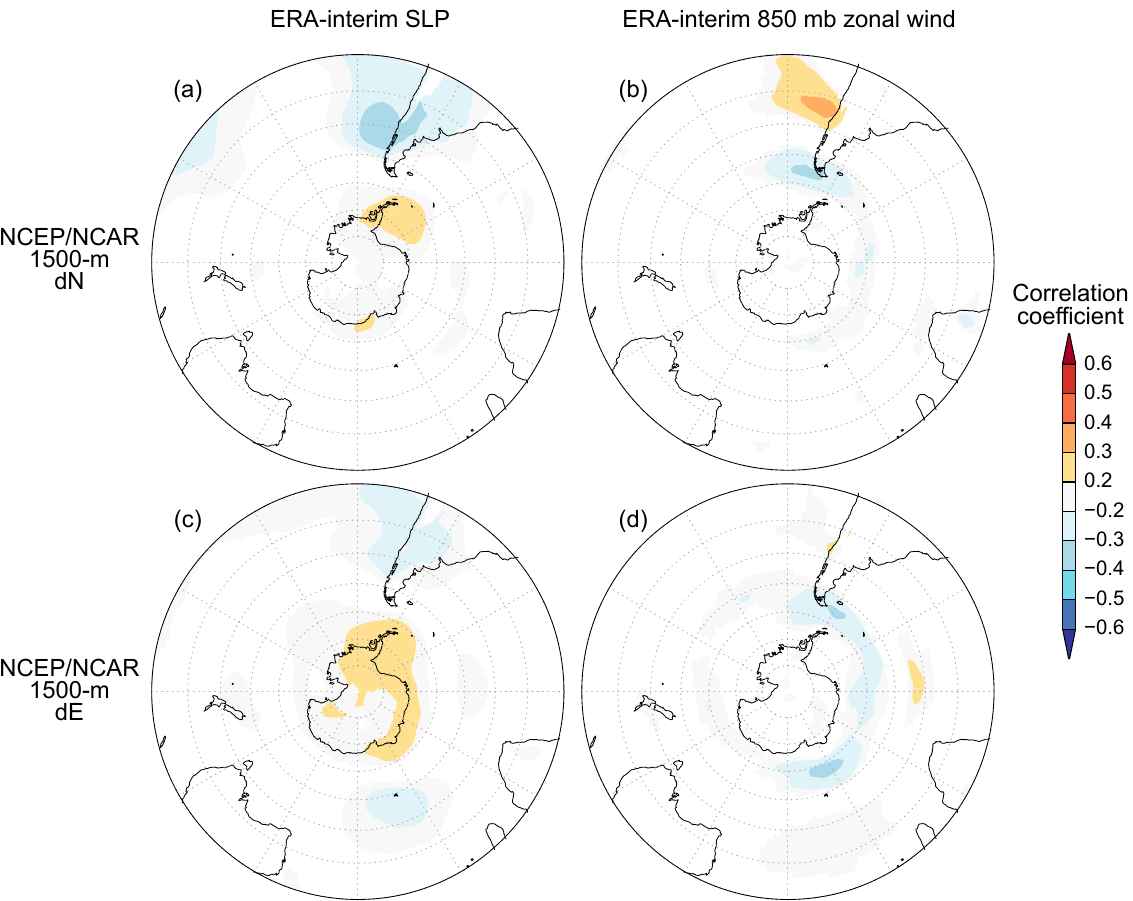
Figure 7. Spatial correlation between NCEP / NCAR-based monthly proportion of precipitation related to northerly ( a , b ) and easterly ( c , d ) trajectory clusters and ERA5 ( a , c ) sea level pressure (SLP) and ( b , d ) 850 mb zonal wind speed fields. The results from an initial back-trajectory height of 1500 m were used because this level is close to 850 mb and likely represents the average level of main precipitating air masses (see Section 4). The dN and dE data from all months during the corresponding periods are used, including those months during which δ 18 O p data were missing or filtered out (see Section 3.1). Areas with p -value higher than 0.1 were masked out. The plots were generated on